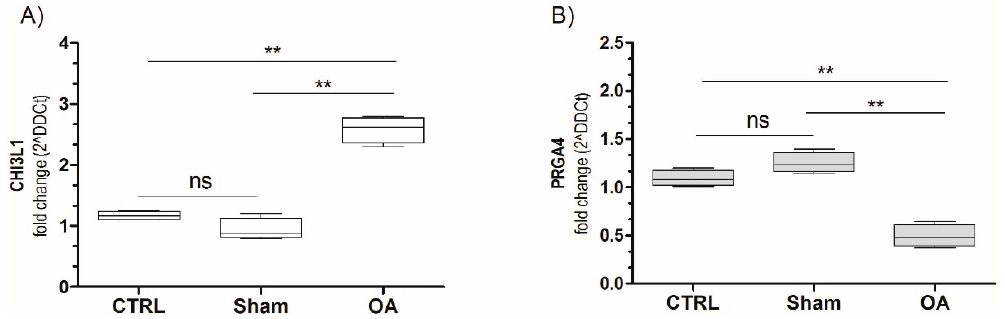
Figure 6. CHI3L1 ( A ) and PRG4 ( B ) mRNA expression in osteoarthritic rat cartilage model. Expression levels of CHI3L1 and PRG4 (lubricin) in cartilage of osteoarthritis rats. Total RNA was extracted as indicated in Materials and Method and CHI3L1/PRG4 expression was measured by real-time PCR. Data are expressed as mean ± SD of at least three independent experiments. ** p < 0.001, compared to sham and control. CTRL: control; ns: not significant.